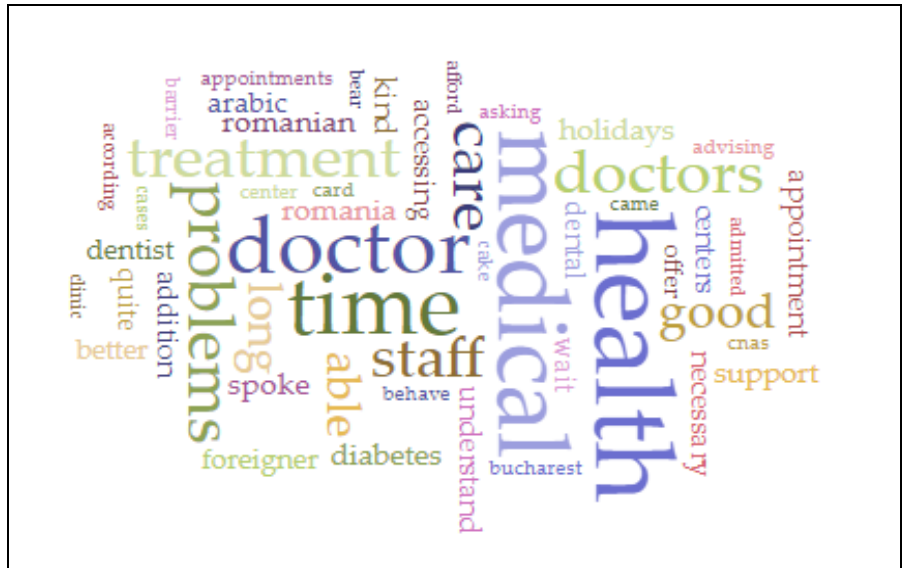
Figure 1. Word cloud on occurrences related to asylum seekers and people with refugee backgrounds’ access to healthcare.